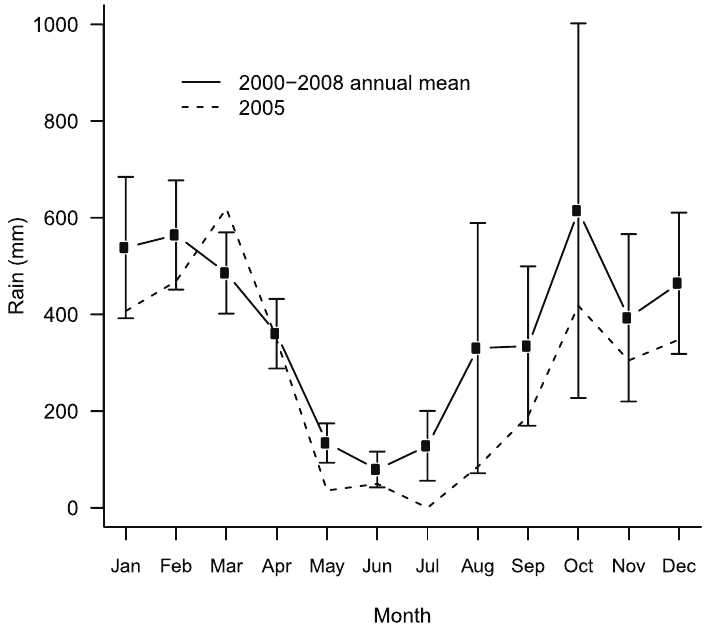
Figure 4. Monthly precipitation (mm) recorded at the Rocotal meteorological station at 2010 m maintained by SENAMHI in the Kosñipata Valley. Monthly means with 95% confidence intervals are shown for 2000–2008 exclusive of 2005, and compared with 2005 monthly